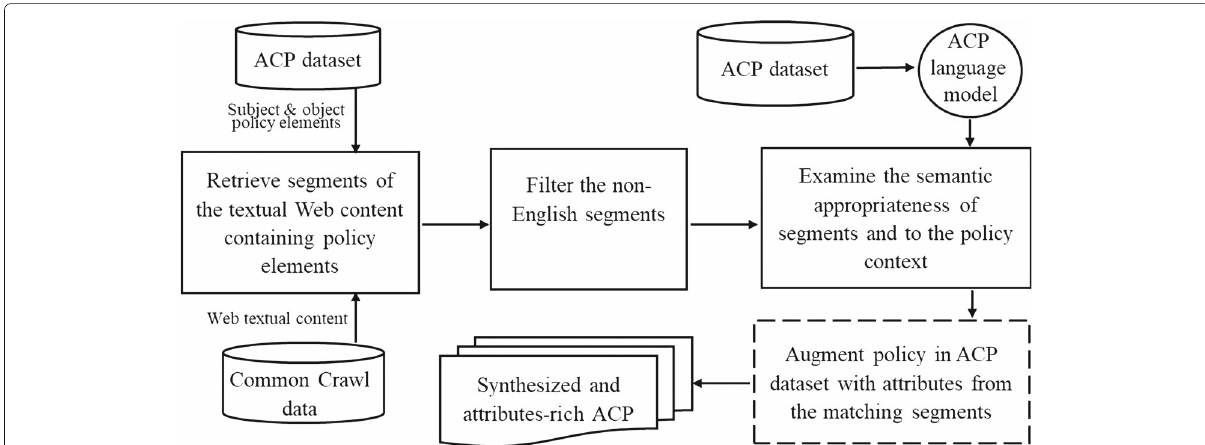
Fig. 9 Synthetic data generation framework. The dashed box indicates the manual task in this